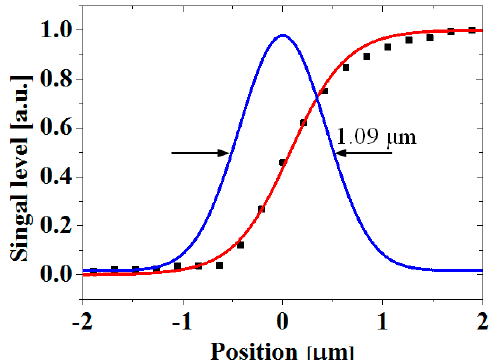
Figure 8. Spatial resolution of backside thermoreflectance measurements obtained using the confocal TRM system with a 100× objective lens (NA 0.5). The symbols (solid squares) are the experimental data indicated by the solid line in Figure 7d and were fitted to an error function (red line). A Gaussian PSF (blue line) was extracted from the derivative of the fitted curve. The positions were measured from the edge of the poly-Si micro resistor.